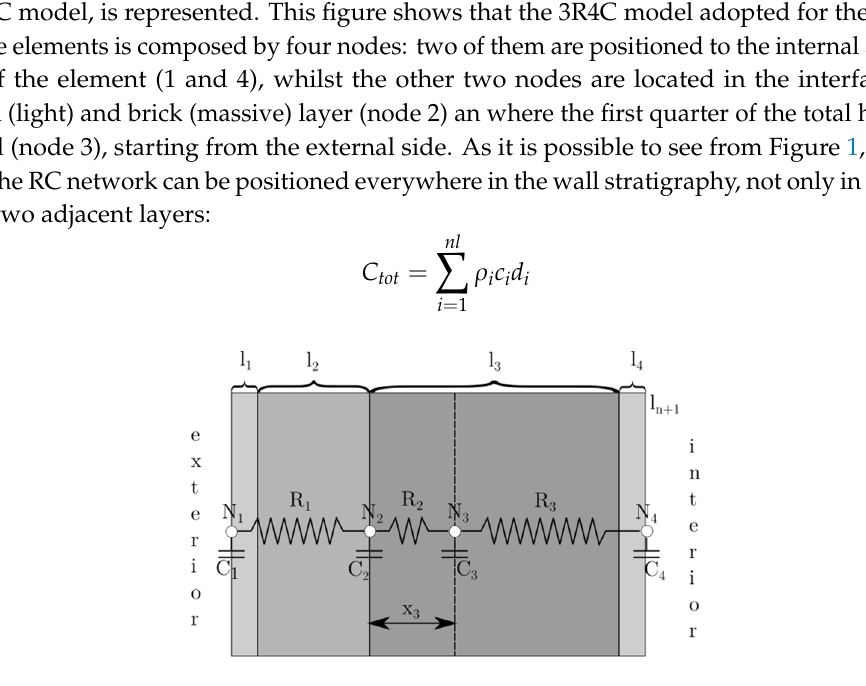
Figure 1. Equivalent 3R4C network associated to an opaque envelope building.